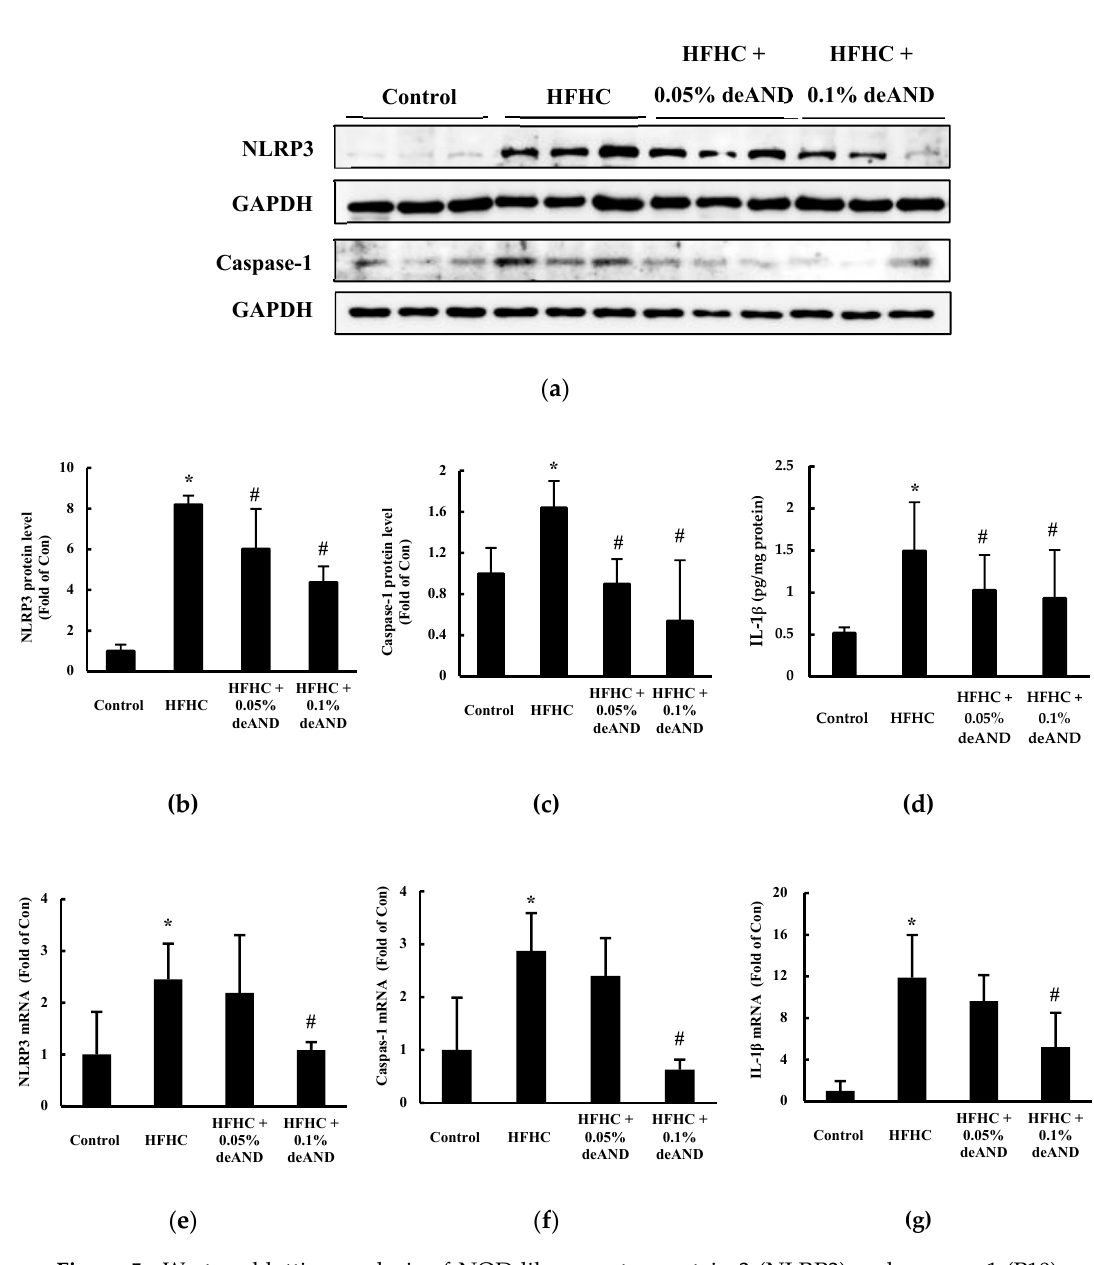
Figure 5. Western blotting analysis of NOD-like receptor protein 3 (NLRP3) and caspase-1 (P10) proteins in the liver ( a ). IL-1 β protein level in liver was determined by a commercial kit as described in Material and Methods. The results show that deAND supplementation reduced the expressions of the proteins ( n = 3 for figure b and c, and n = 6 for d ) and mRNA ( n = 6 for figure e–g ) of NLRP3, caspase-1, and IL-1 β in liver. The protein band was quantified by densitometry and mRNA expression level was calculated by the 2 - ΔΔ CT method, respectively. * Significantly different from the Control group at p < 0.05. # Significantly different from the HFHC group, p < 0.05.